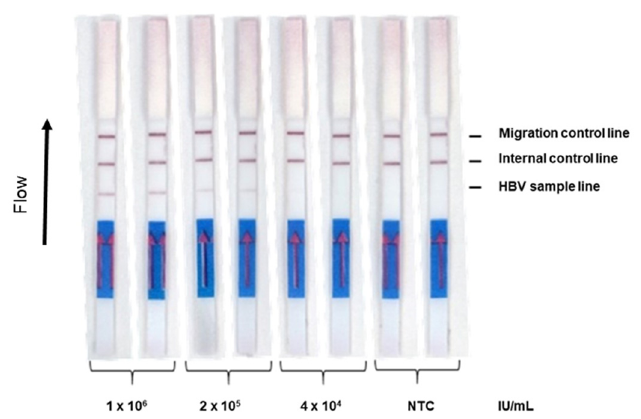
Figure 4. Detection limit of the HBV RPA-LFA (500 µ L). To determine the detection limit of RPA-LFA in the format of extraction using 500 µ L 5% Chelex 100, five-fold serial dilutions of the HBV standard control ranging from viral loads of 1 × 10 6 IU/mL to 4 × 10 4 IU/mL were tested. Each dilution was tested in duplicate. NTC refers to non-template control.